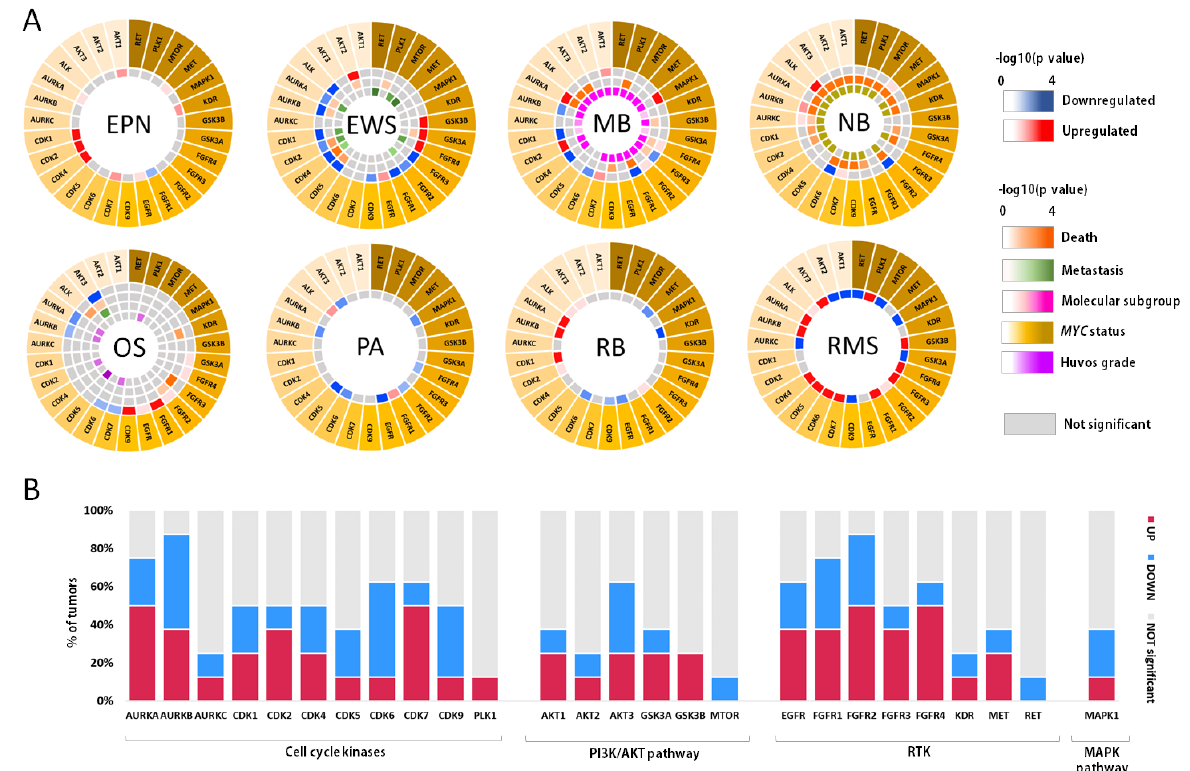
Figure 3. ( A ) Polar plots of differentially expressed kinases in pediatric tumors obtained through the analysis of available data on the R2: Genomics Analysis and Visualization Platform (http://r2.amc.nl (accessed on 15 October 2022)). Tumor abbreviations: EPN—ependymoma; EWS—Ewing sar-